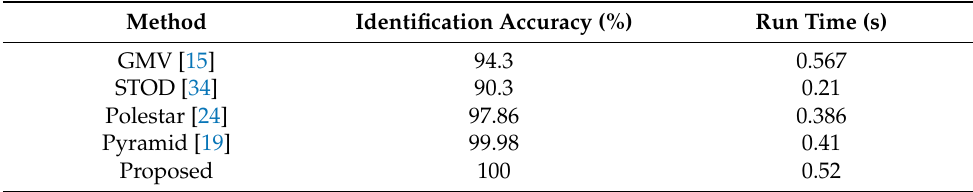
Table 1. Benchmarking of star identification methods—ideal